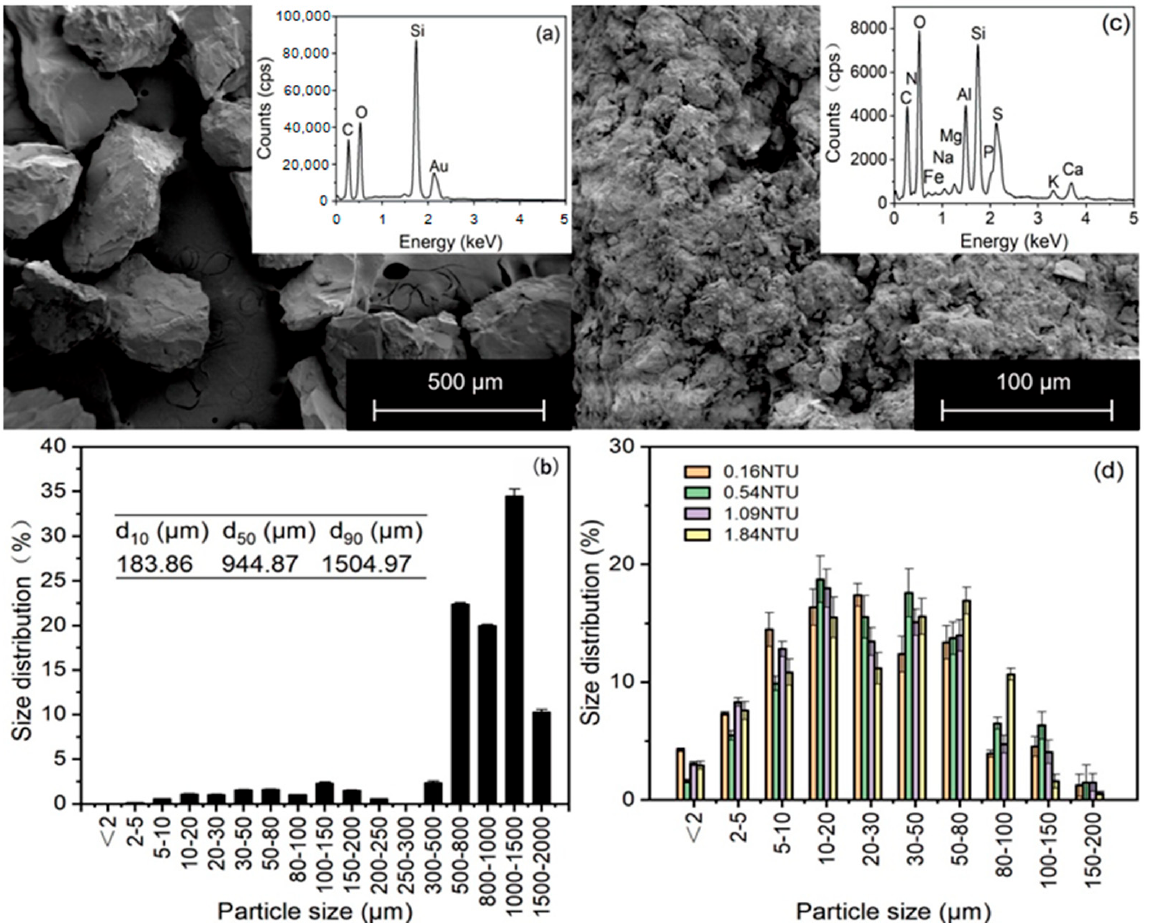
Figure 1. ( a ) Scanning electron microscopy (SEM) equipped with energy-dispersive X-ray (EDX) spectra of quartz sand. ( b ) SEM micrograph and EDX spectrum of suspended particles in the SE. ( c ) Size distribution of sand grains. ( d ) Size distribution of suspended particles in the SE.